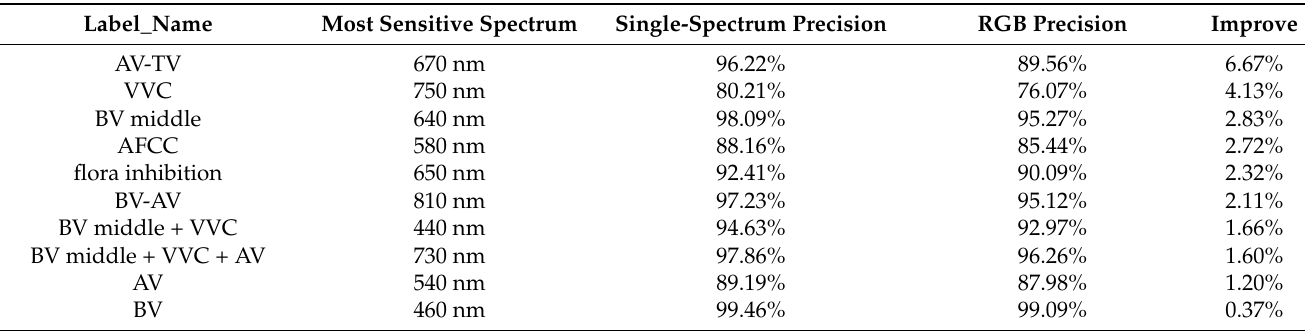
Table 9. Binary classification result of single-spectrum image and RGB image, and AFCC is abnormal flora combined